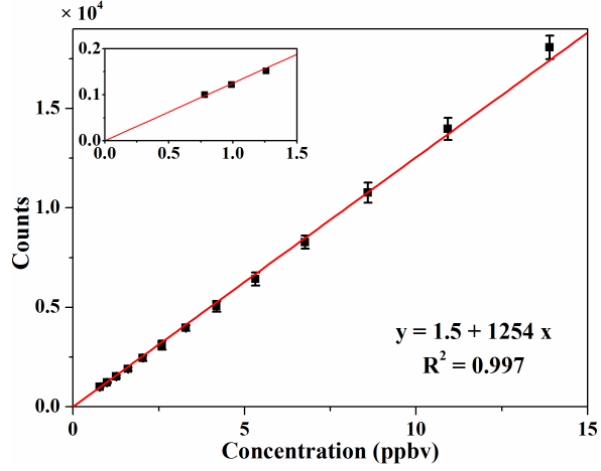
Figure 3. Signal intensities versus concentrations of benzene mea- sured by the VUV-PIMS equipped with photoionizer B. Black squares represent the data points, and the line represents the result from linear fitting. Figure 4. Mass spectrum of outdoor air obtained using the VUV-